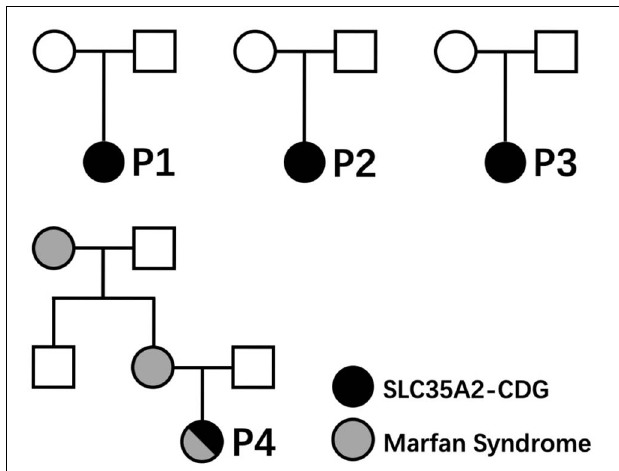
FIGURE 2 | Pedigrees of patients reported in this